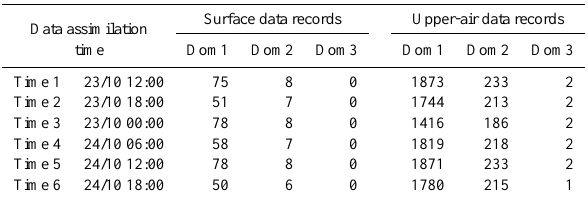
Table 1. Number of NCAR data records distributed inside each of the triple nested domains.